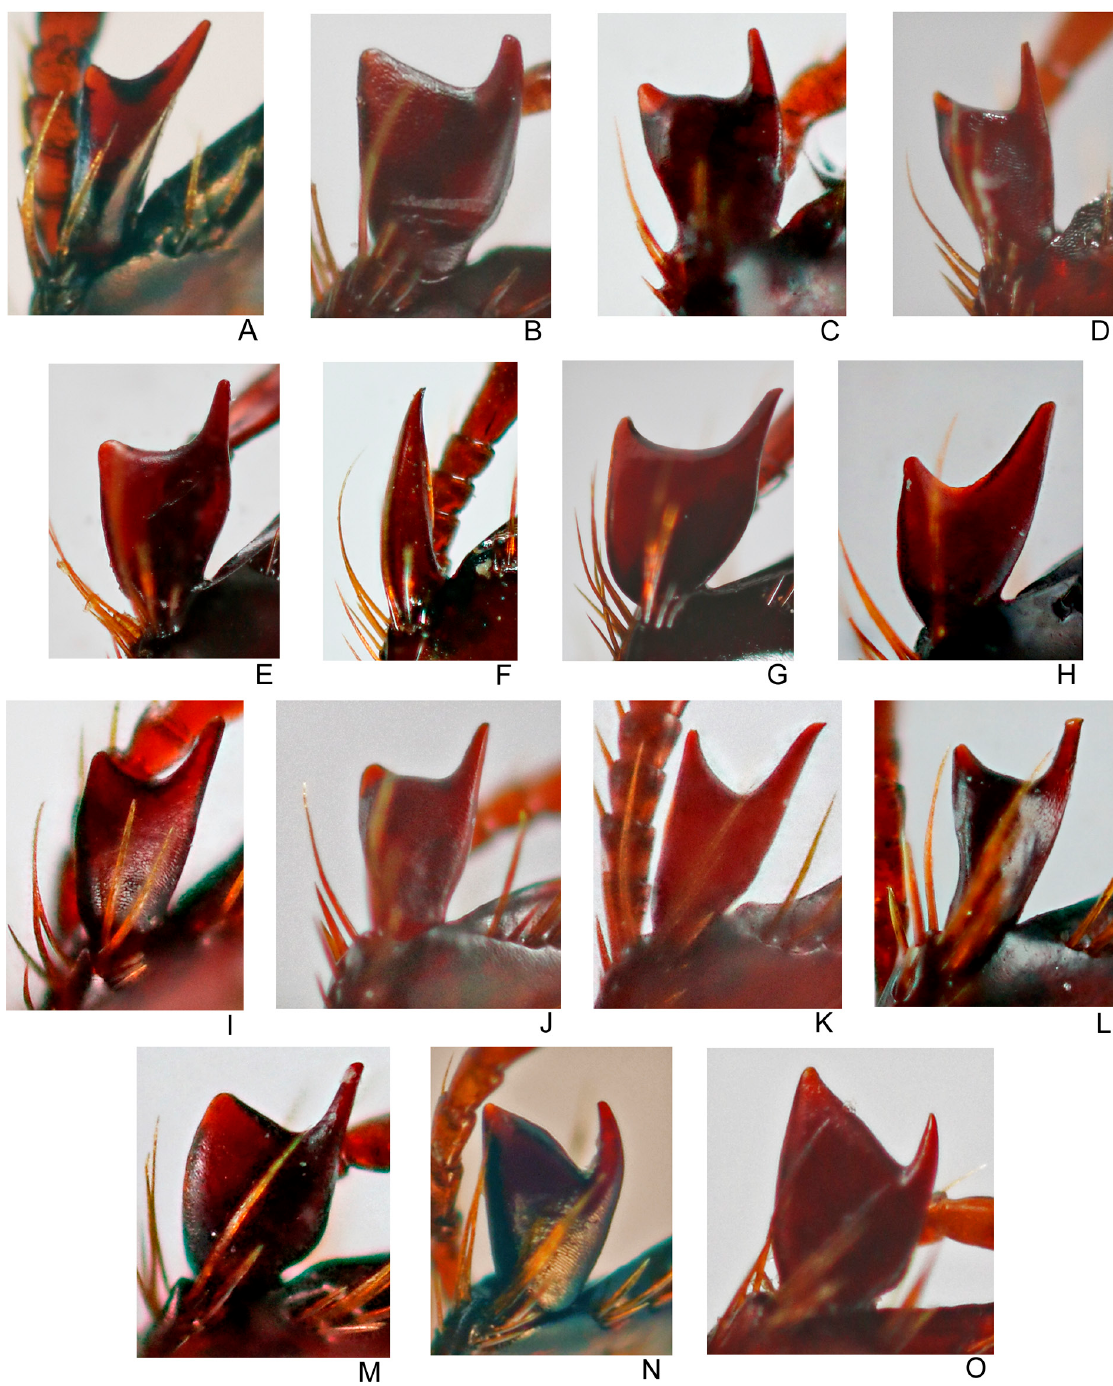
Fig. 15. Morphological variation and sexual dimorphism in the protibial spur of Sylvicanthon